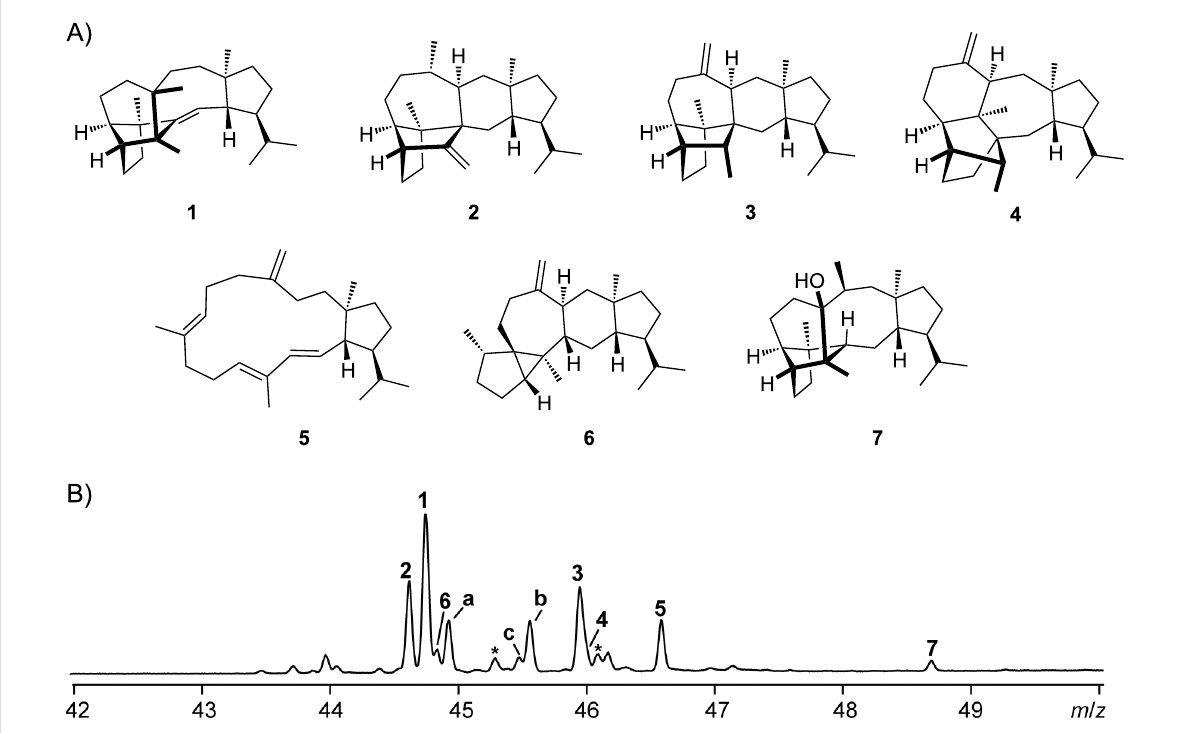
Figure 2: The products of SmTS1. A) Structures of sestermobaraenes A–F ( 1 – 6 ) and sestermobaraol ( 7 ). B) The total ion chromatogram of the prod- ucts obtained with SmTS1 from GFPP. Peak labels a , b and c indicate unknown products, asterisks indicate degradation products from GFPP that are also observed without enzyme.